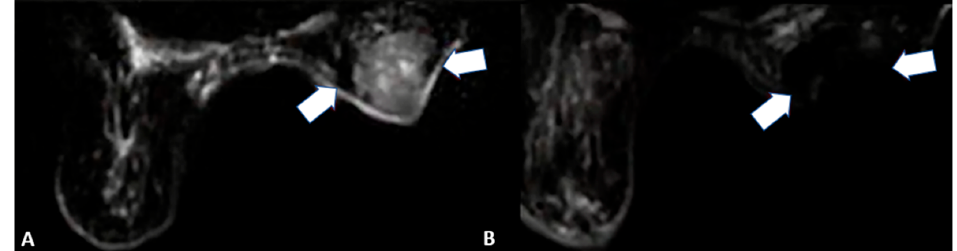
Figure 6. 85-year-old female patient with invasive right breast cancer with axillary metastases. Diffusion-weighted imaging MRI scan showing ( A ) baseline large neoplastic lesion infiltrating the skin and soft tissues (arrows) and ( B ) 4-month follow-up after microwave ablation with absent signal restriction (arrows).